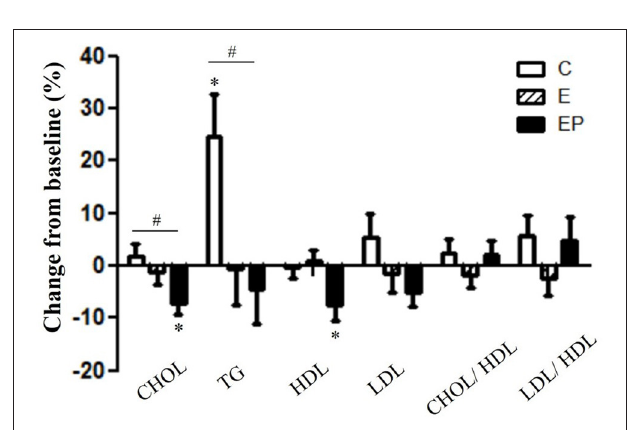
FIGURE 5 | Effects of intervention on lipid profiles. Data were presented as mean ± SE. # Significantly different between groups analyzed by ANCOVA and the Bonferroni test; *Significant change from the baseline. C, control group; CHOL, total cholesterol; E, exercise group; EP, exercise combined with high-protein diet group; HDL, high-density lipoprotein; LDL, low-density